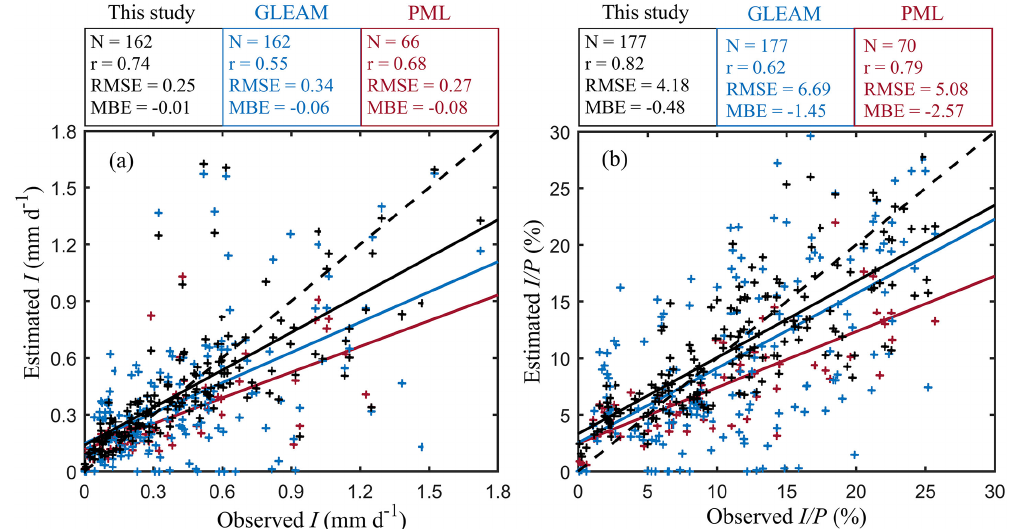
Figure 9. Field validation of rainfall interception loss from three different models. (a) I (in mmd − 1 ) and (b) I/P (in %). Black, blue and red scatters represent the pixel-scale simulations from this study, GLEAM and PML model, respectively. Since the time series of PML v2 spans from 2003 to 2017, only 70 field observations can be used for validation. The solid lines in different colours are the regression lines, and the dashed black lines mark the 1-to-1